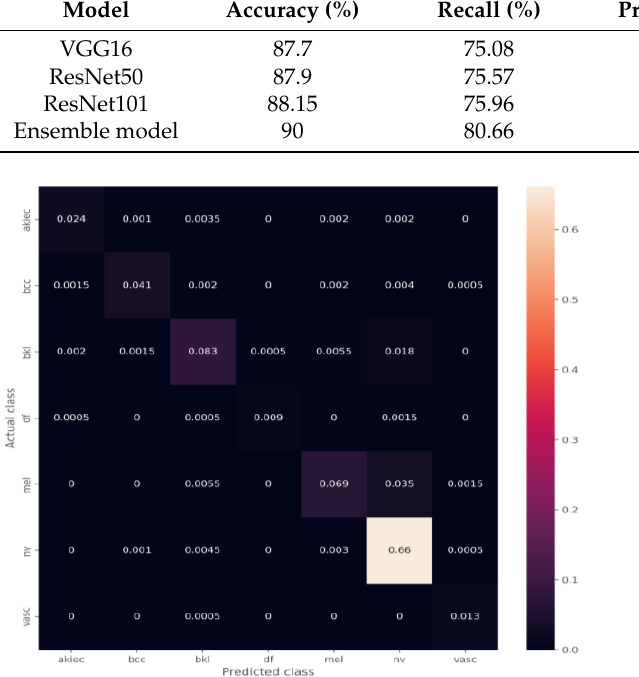
Table 4. Class-wise performance of the ensemble models on balanced and unbalanced datasets.